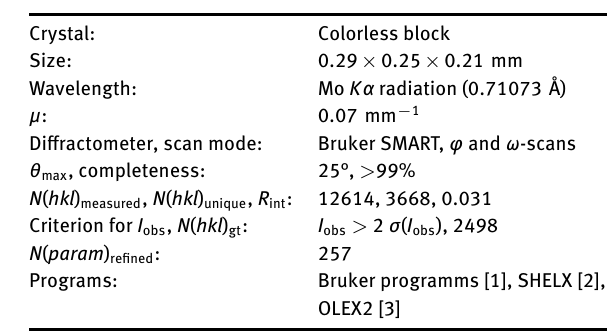
Table 1: Data collection and handling.